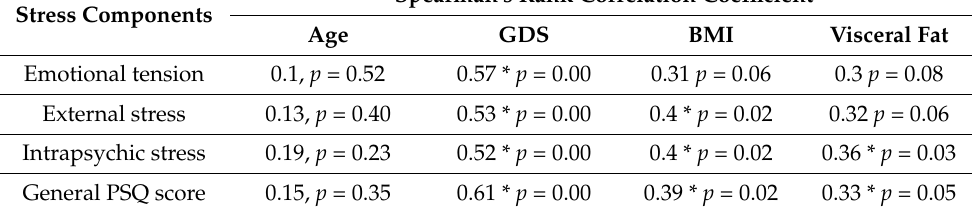
Table 4. The coefficients of correlation of stress with age, the GDS, the BMI, and visceral fat in the study group.